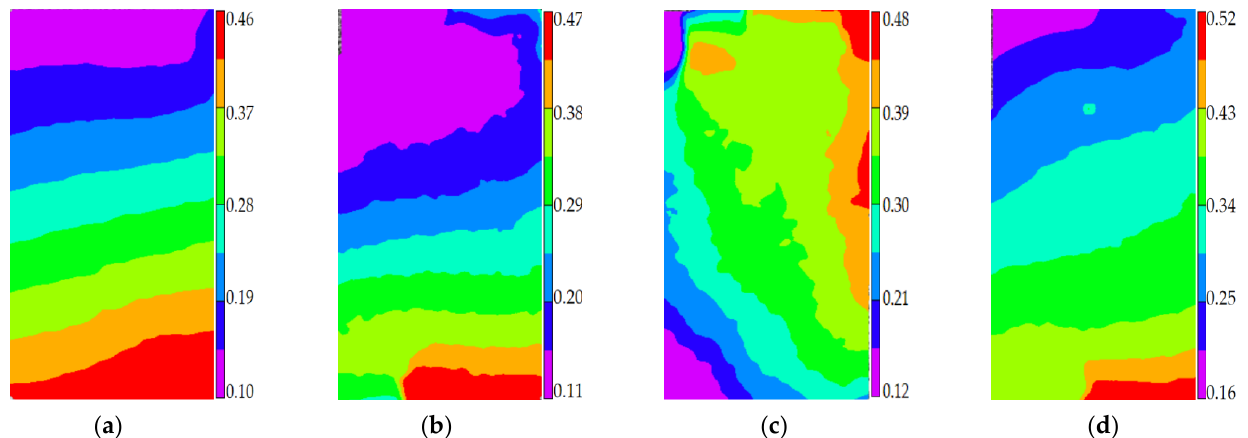
Figure 15. The horizontal strain cloud diagram of concrete with different coarse aggregate volume fraction at the peak point of damage stage II, ( a ) 9.5 mm, ( b ) 19 mm, ( c ) 26.5 mm, ( d ) 31.5 mm.